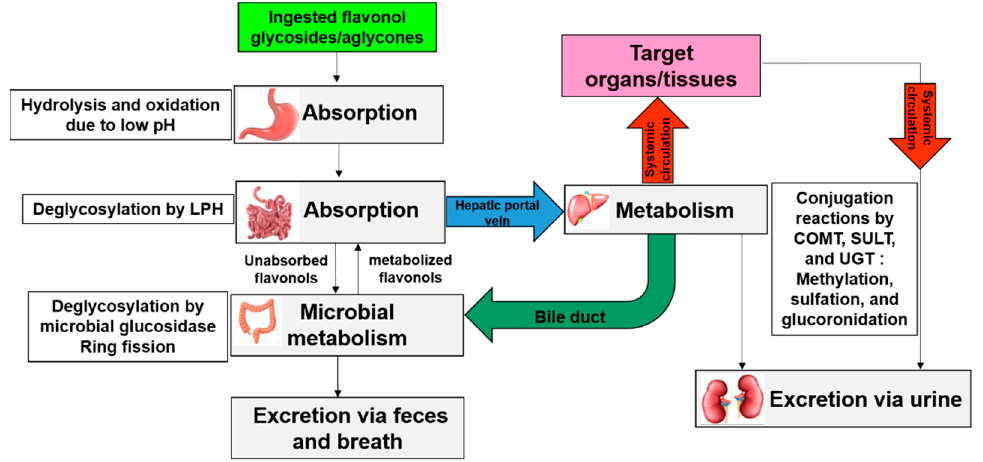
Figure 4. A simplified schematic representation of oral bioavailability of flavonols in humans. LPH, phlorizin lactase; COMT, catechol- O -methyl-transferases; SULT, sulfotransferases; UGT, uridine 5’-diphospho-glucuronosyl transferases.